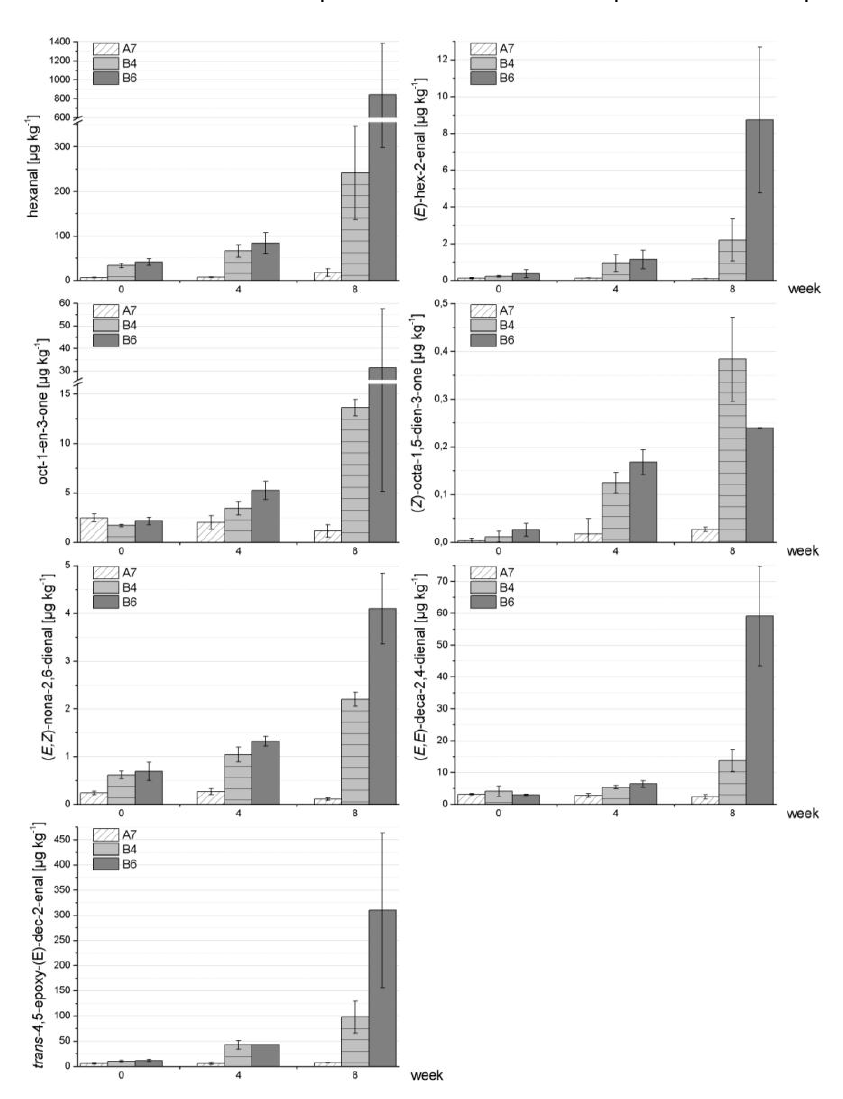
Figure 2. Example of a stable formulation (A7) in comparison to two less stable formulations (B4, B6) with respect to lipid autoxidation/formation of secondary lipid oxidation markers. Reconstitution of powdered formulas was performed in